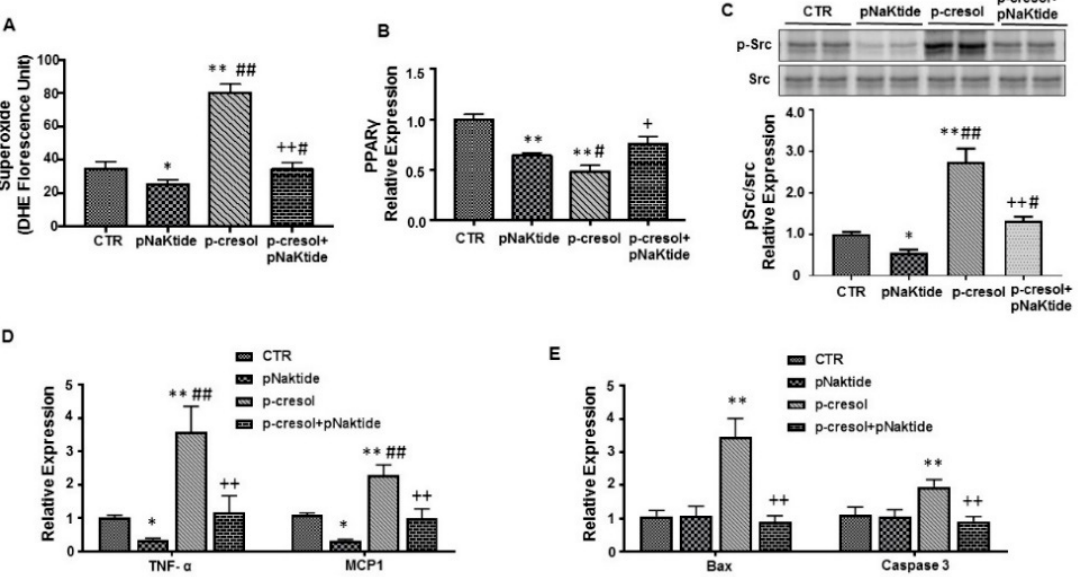
Figure 4. ( A ) Effect of p-cresol 100 µ M in 3T3-L1 cells treated with or without pNaKtide for superoxide levels assessed with DHE staining; ( B ) RT PCR analysis for the expression of adipogenic marker, PPAR γ ; ( C ) representative Western blots for Src activation; ( D ) RT PCR analysis for the expression of pro-inflammatory markers TNF- α and MCP-1; and ( E ) RT PCR analysis for the expression of pro-apoptotic markers, Bax and Caspase 3. Values represent means ± SEM ( n = 6). * p < 0.05 vs. CTR, ** p < 0.01 vs. CTR, # p < 0.05 vs. pNaKtide, ## p < 0.01 vs. pNaKtide, + p < 0.05 vs. p-cresol, ++ p < 0.01 vs. p ‐ cresol.